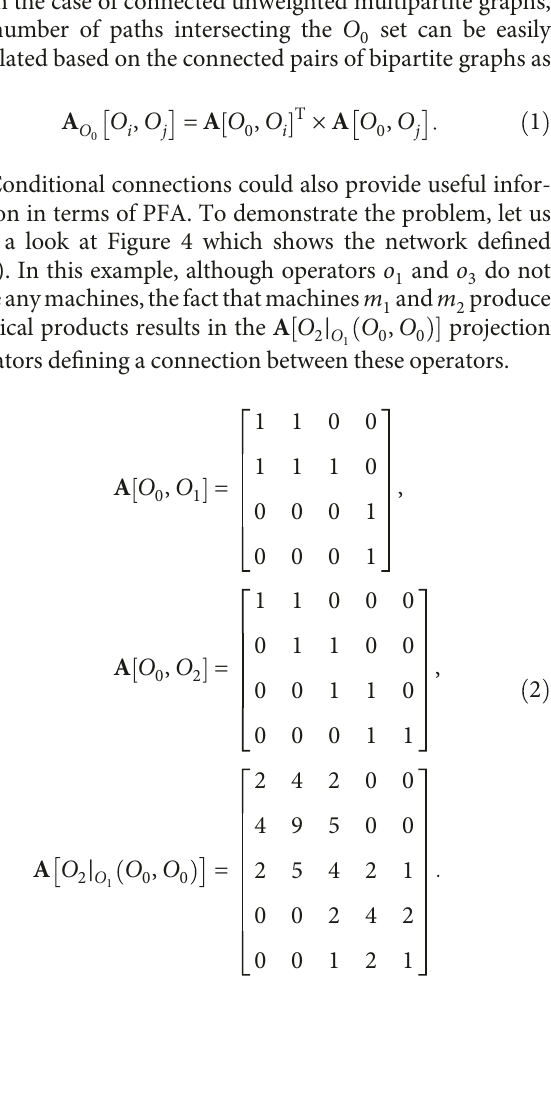
Table 5: The ADACOR predicates can be directly applied to de fi ne layers of the network [36] (please note that we use the term activity to refer to